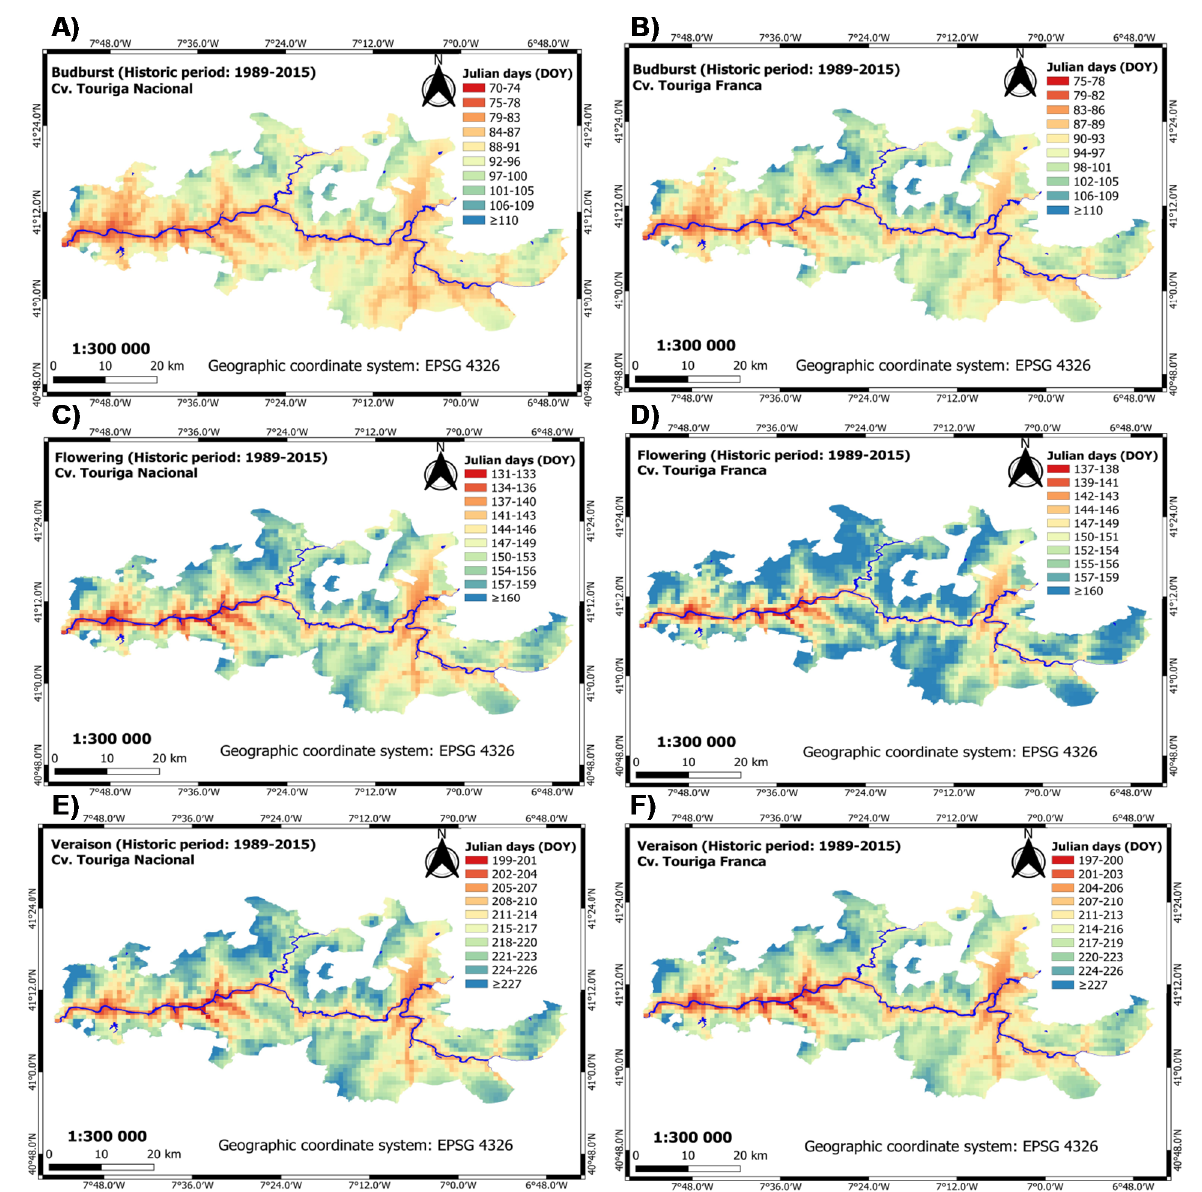
Figure 2. Phenology maps for the historic period (1989–2015) covering the entire Douro Demarcated Region. A color scale represents the Julian days (DOY) obtained by the phenology models for each phenological stage, namely budburst ( A , B ), flowering ( C , D ) and veraison ( E , F ) of the varieties cv. Touriga Nacional (left) and Touriga Franca (right). The Douro river and main tributaries are also outlined (thick blue line).